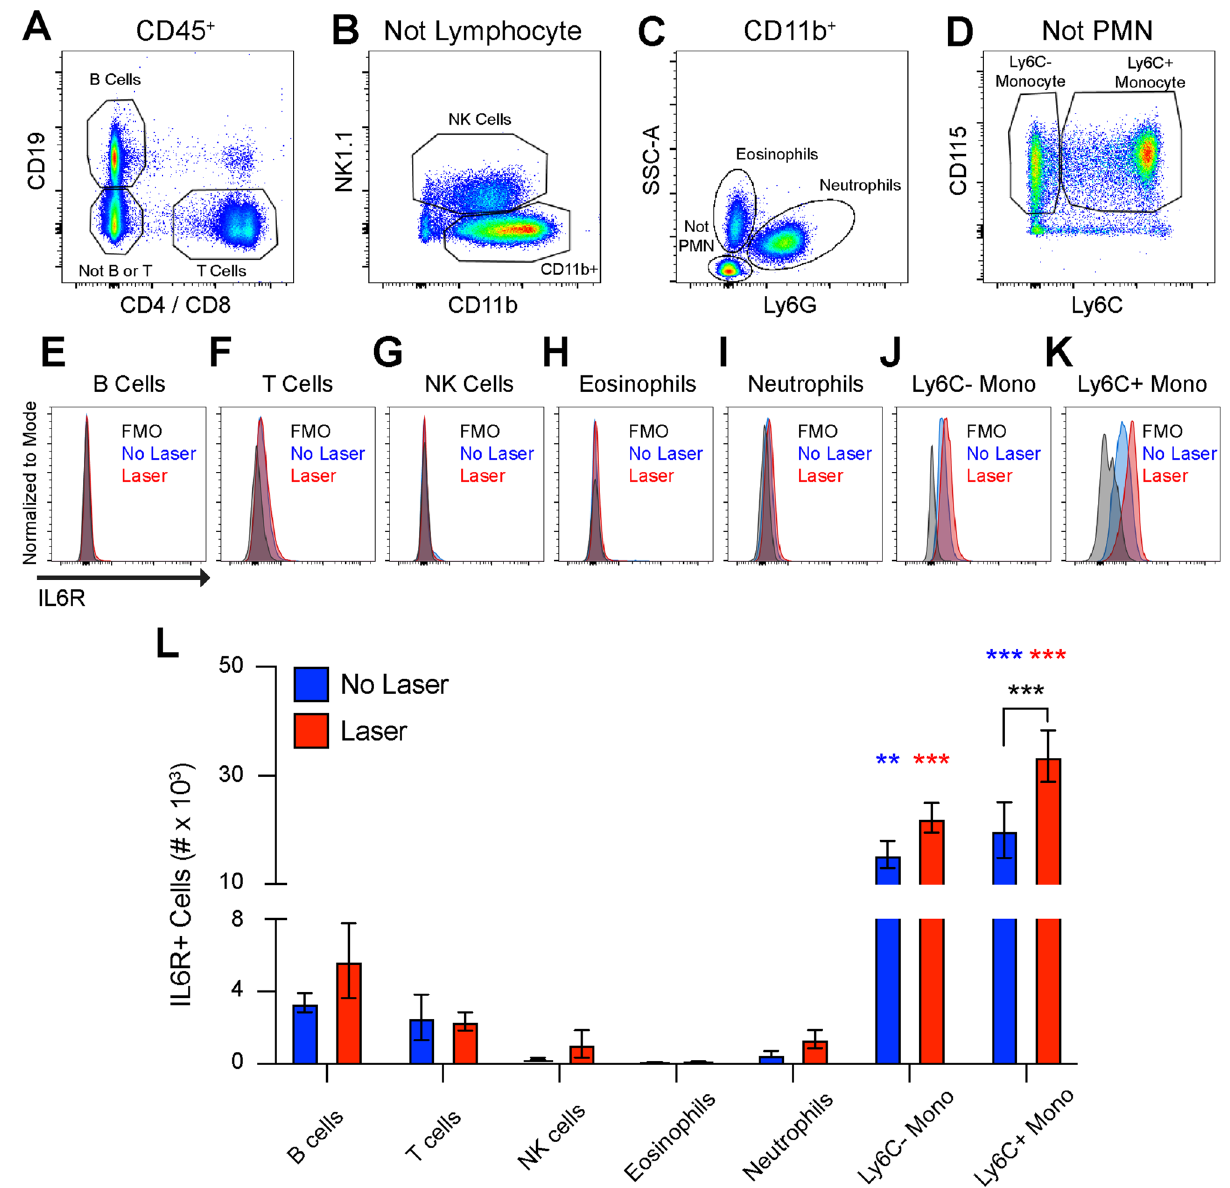
Figure 6. Monocytes express the IL6R in peripheral blood. ( A ) B cells were defined as CD19 + , T cells were defined as CD4 + or CD8 + , and non-lymphocytes (not B or T) were gated forward. ( B ) NK cells were delineated as NK1.1 + and CD11b + NK1.1 − cells were gated forward. ( C ) Neutrophils were identified as Ly6G + SSC med , eosinophils were found to be SSC high Ly6G − , and non-granulocytes (Not PMN) were gated forward. ( D ) Monocytes were defined as CD115 + Ly6C − or CD115 + Ly6C + . ( E – K ) Representative frequency histograms for IL6R expression from the fluorescence minus one (FMO) control, untreated (No Laser, Blue), and lasered (Laser, Red) mice in B cells ( E ), T cells ( F ), NK cells ( G ), Eosinophils ( H ), Neutrophils ( I ), Ly6C − monocytes ( J ), and Ly6C + monocytes ( K ). L: All cells other than monocytes were < 5% IL6R + . At steady state, Ly6C − and Ly6C + monocytes expressed more IL6R than all other groups (** = p < 0.01, *** = p < 0.001 vs all other groups [Blue vs No Laser], N = 5–6 per group). After laser injury, more IL6R + Ly6C − and IL6R + Ly6C + monocytes detected compared to all other groups (*** = p < 0.001 vs all other groups [Red vs Laser], N = 5–6 per group). The number of IL6R + Ly6C + monocytes were increased by laser treatment (*** = p < 0.001, Black: No Laser vs Laser, N = 5–6 per